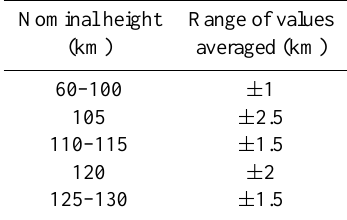
Table 1. Reduction of electron density to 5-km